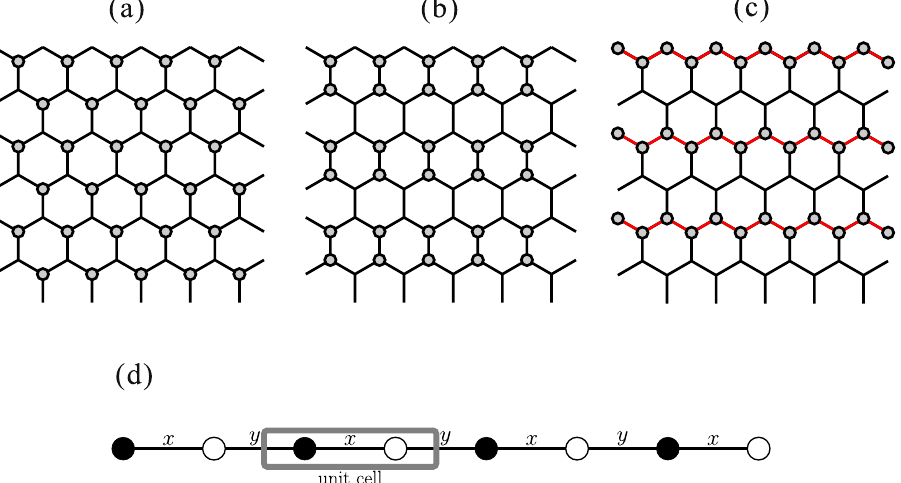
Figure 1. Possible charge ordering patterns of K 0.5 RuCl 3 ; ( a ) triangular, ( b ) dimer and ( c ) zigzag. ( d ) Lattice structure of the 1D Heisenberg-Kitaev model. The labels ‘ x ’ and ‘ y ’ indicate the x -bond and y -bond, respectively (see